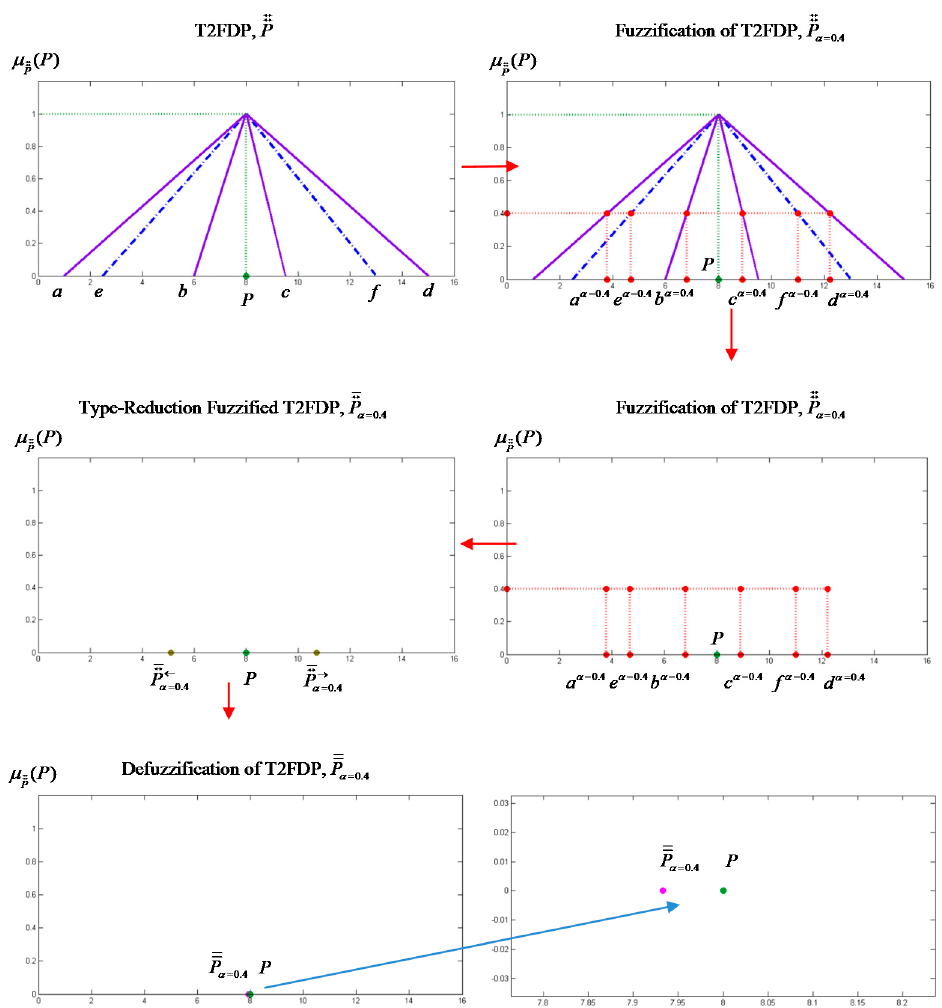
Figure 5. The processes of defining, fuzzification, type-reduction and defuzzification towards